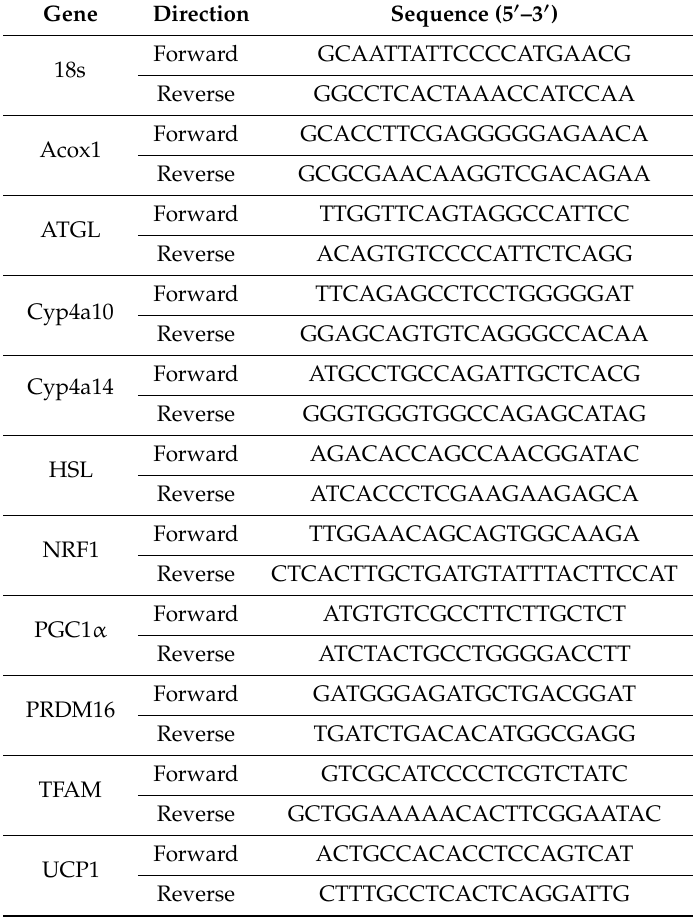
Table2. Primersequencesusedforquantitativereversetranscriptionpolymerasechainreactionanalysis. Gene Direction Sequence (5 (cid:48) –3 (cid:48)